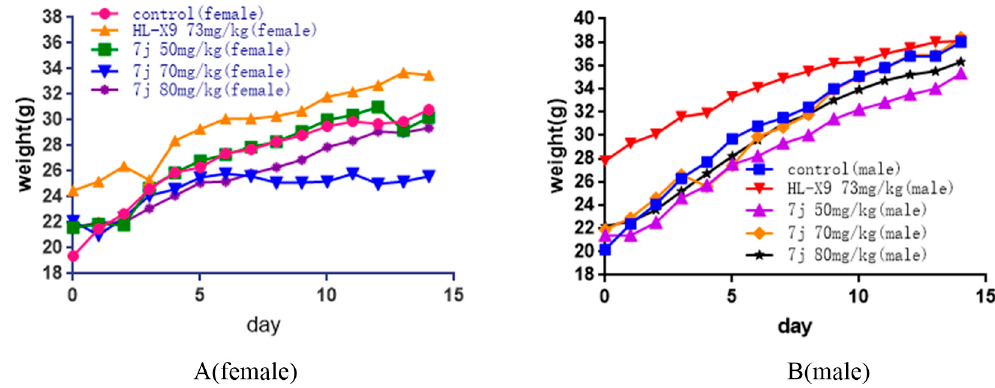
Figure 5. Weight change. A : Female; B : Male.